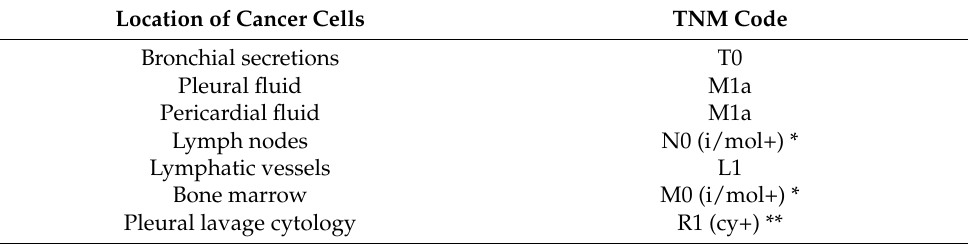
Table 5. Lung cancer cells that count for the TNM classification and have their specific code. Location of Cancer